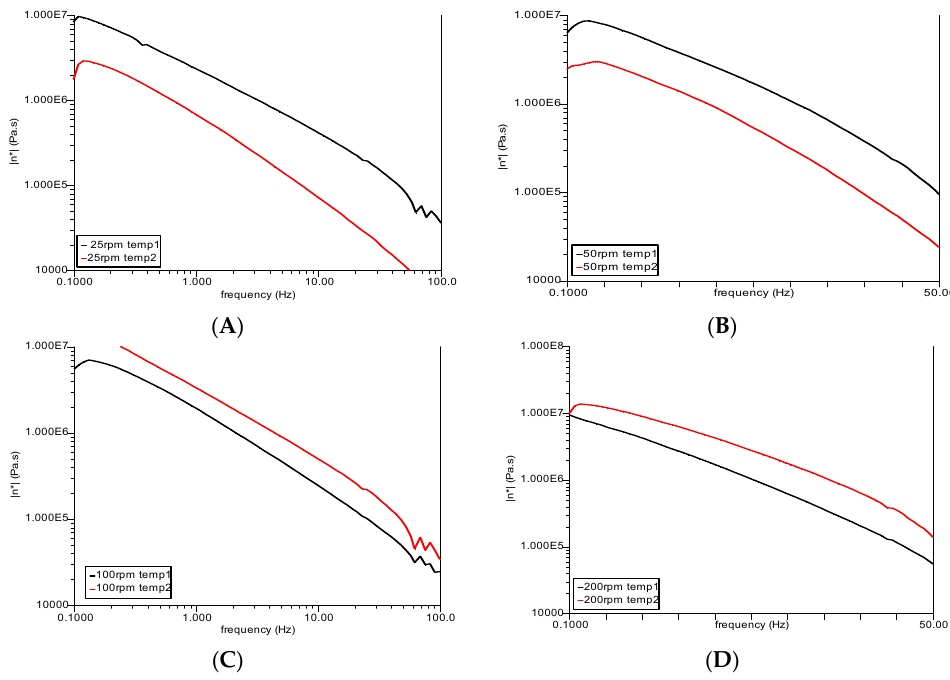
Figure 9. Complex viscosity ( η *) of Shellac samples produced by different temperature profiles and screw speeds: ( A ) 25 rpm; ( B ) 50 rpm; ( C ) 100 rpm and ( D ) 200 rpm.